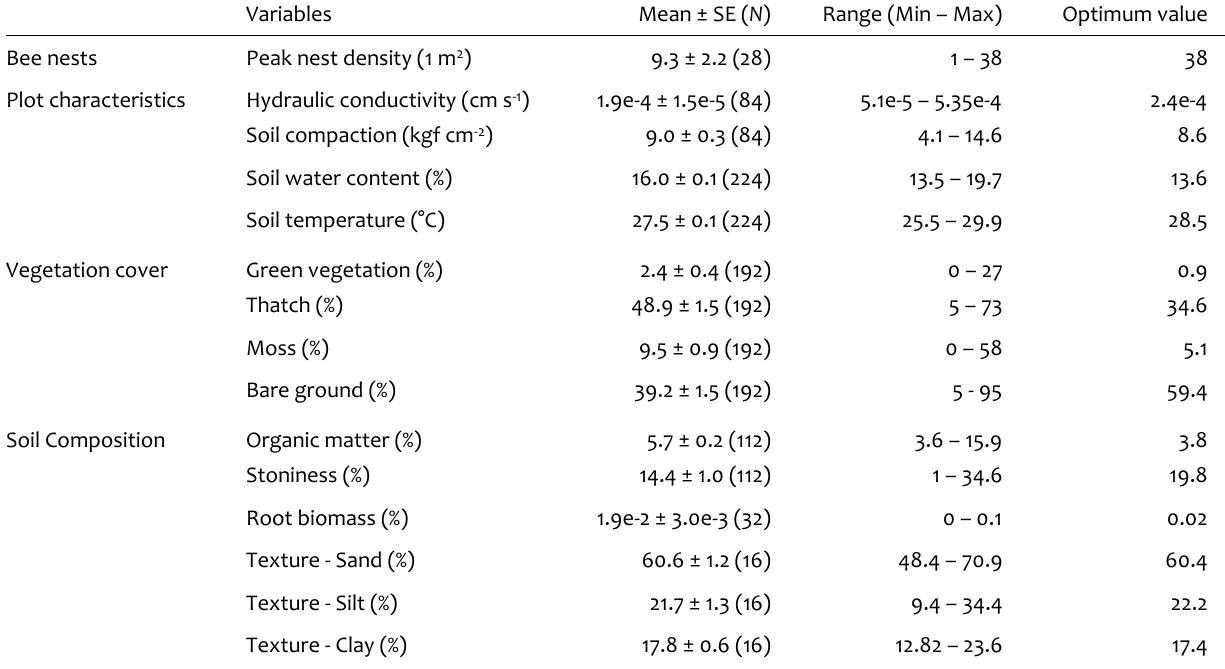
Table 1: Mean ± SE, range and optimum values for soil and vegetation variables measured from eight study plots in 2018 and